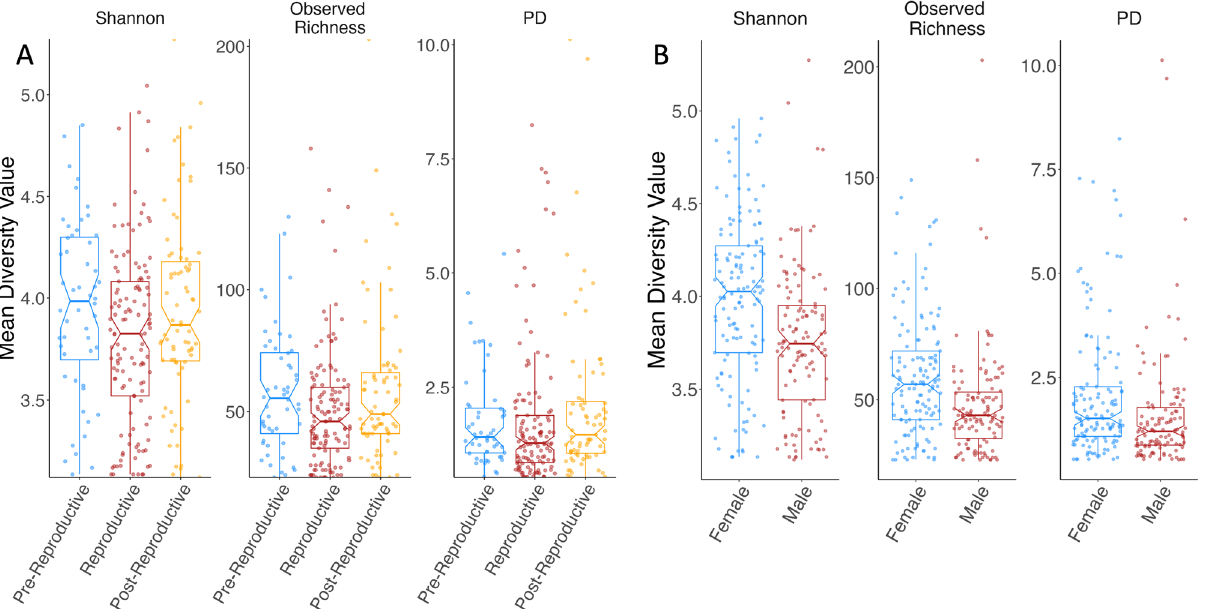
Figure 4. Diversity (Shannon index), Observed Richness, and Faith’s phylogenetic diversity (PD) of cloacal microbiomes ( A ) for S. virgatus over three reproductive seasons, and ( B ) for males and females across the entire active period (April through September). Boxes represent median and quartiles, while whiskers indicate 95% confidence intervals. Female reproductive